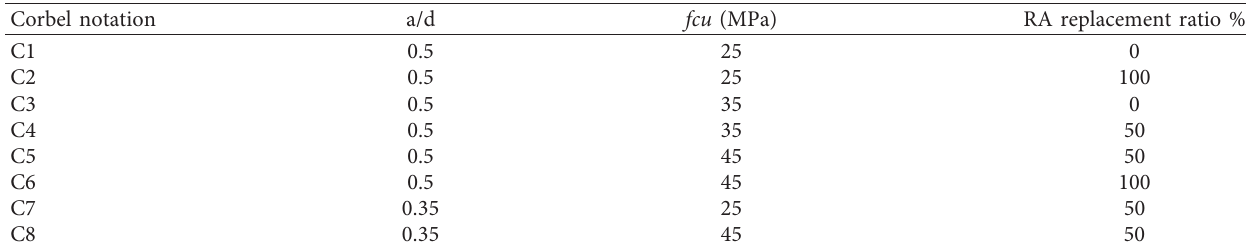
Figure 1: Details of corbels and reinforcement. Table 1: Details of corbels.